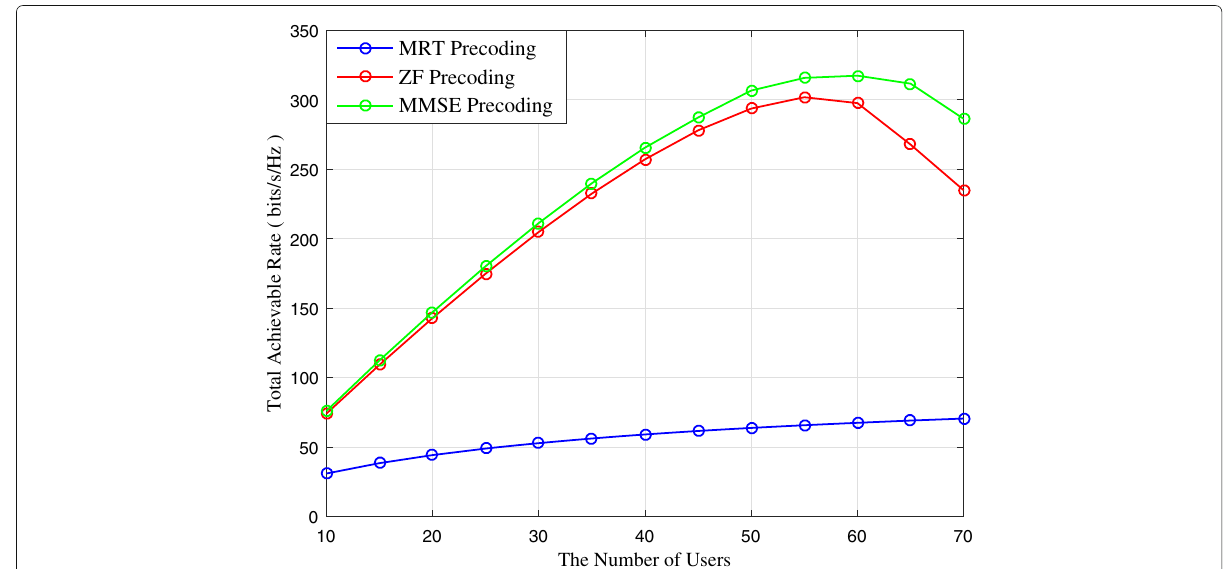
Fig. 4 Comparison of the total achievable rate versus the number of users for MRT, ZF, and MMSE precoding schemes. Results are shown for N t = 70 and SNR ρ = 5